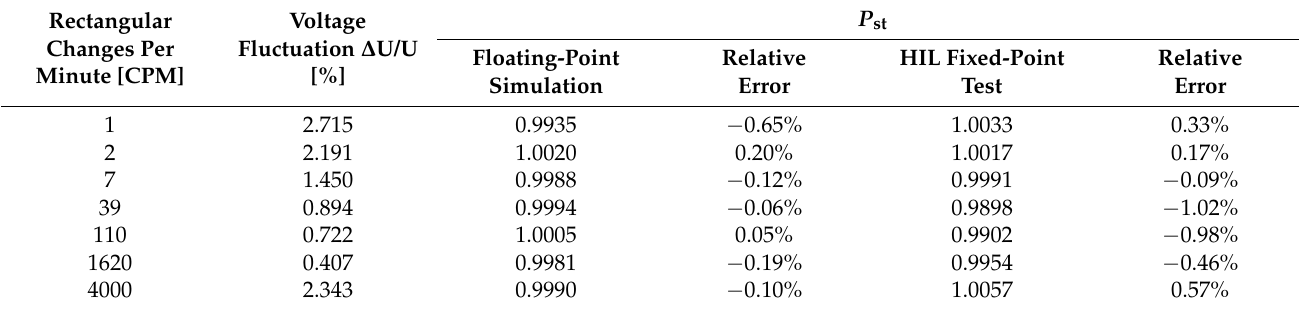
Table 4. Rectangular voltage changes and performance testing.